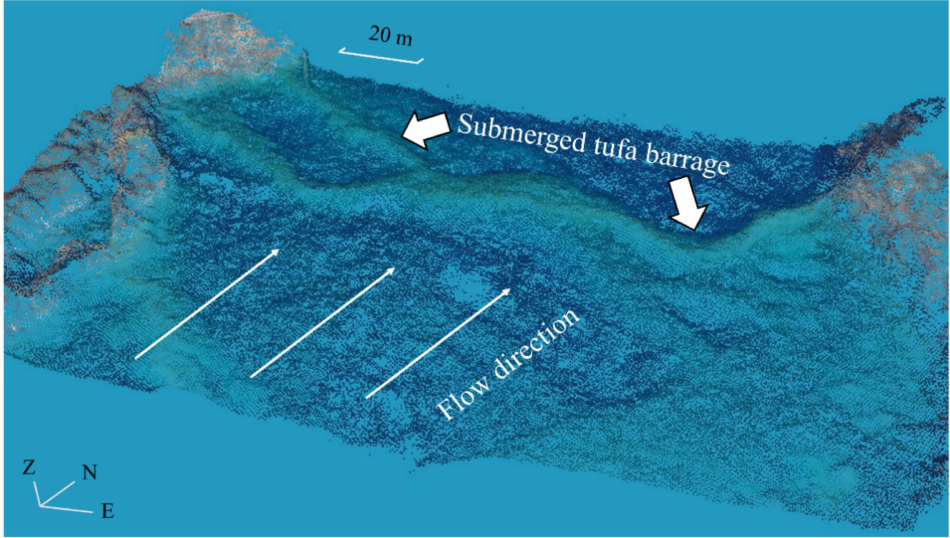
Figure 5. Dense point cloud after the SfM-MVS workflow; the submerged tufa barrage is marked. In the generated DSM, we extracted the extent of the submerged tufa barrage, which was the initial topography of the tufa barrage, namely the initial DEM. Based on the initial DEM, the corresponding aspect and slope of the barrage were further computed and generated (Figure 6). As mentioned earlier, fluvial tufa barrages are often perpendicular to the direction of water flow [5]. In our case, the water flows from south to north, so the barrage body is determined to have an east–west trend. On the other hand, because the tufa barrage in our study is located in the Northern Hemisphere, the slope with an aspect angle between 90 ◦ and 270 ◦ is a sunny slope; otherwise, it is shady slope. The boundary between the sunny slope and the shady slope represents the highest the point of tufa barrage crest. For determination of the tufa barrage height, the lowest elevation of the lakebed of Lying Dragon Lake (2215 m) was used as the barrage base [33]. The height of the barrage body is the difference in elevation between the highest local point of the barrage crest and the barrage base, which is the initial height of submerged tufa barrage. Finally, the initial height was extracted from the initial DEM of the tufa